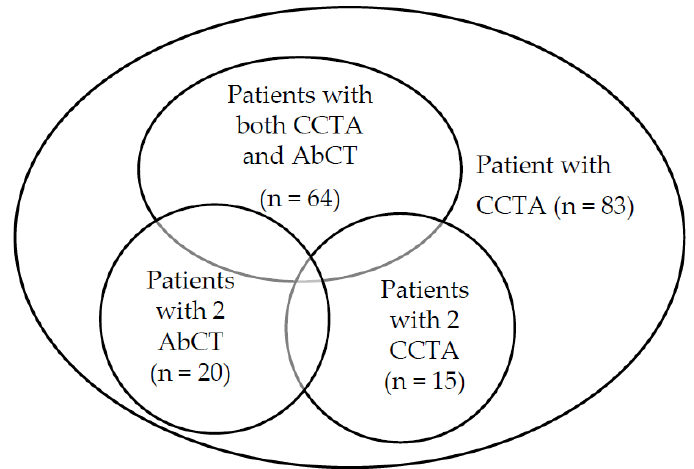
Figure 1. The sample population and the corresponding CACS, AACS results.